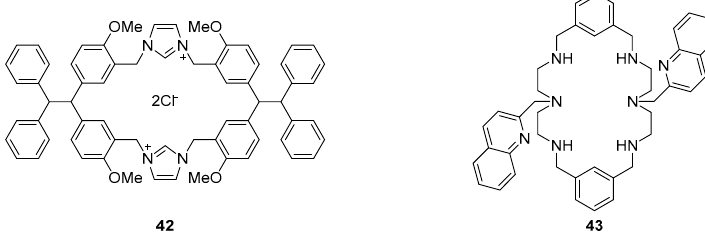
Figure 18. Combining Zn 2+ with either of the macrocycles 42 and 43 affords highly effective probes for pyrophosphate anion (PPi). A solution containing TPE/imidazolium macrocycle